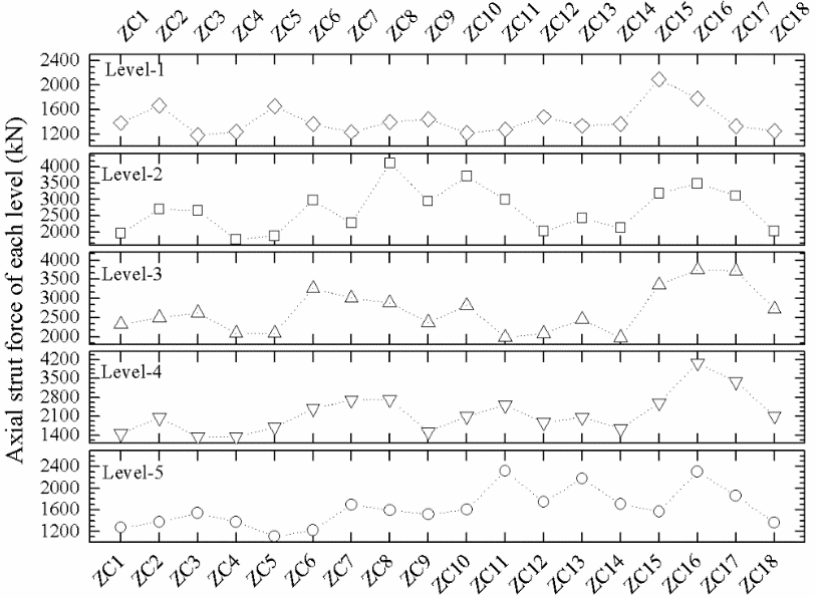
Figure 19. Axial strut forces upon the completion of excavation.